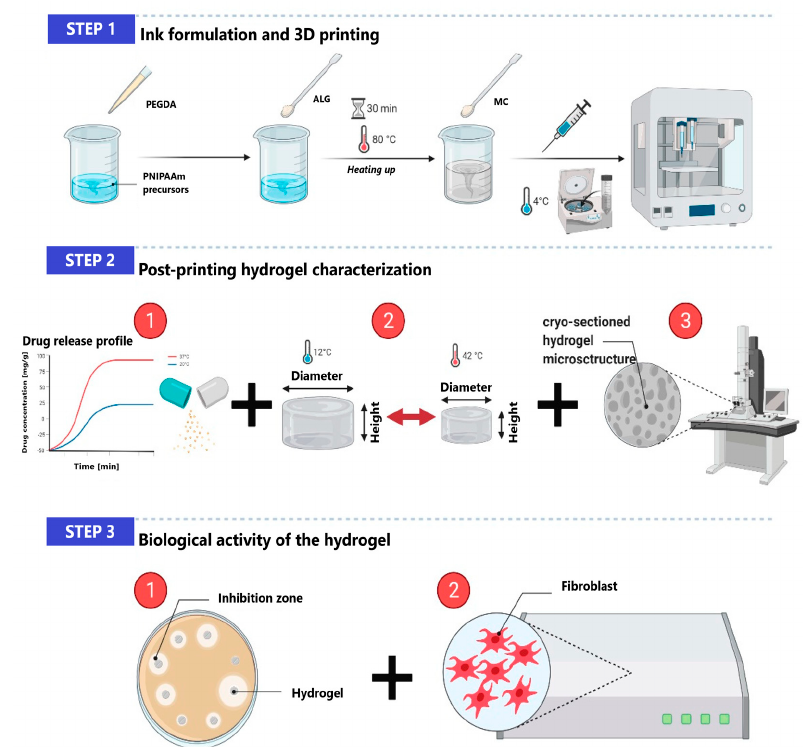
Figure 10. Preparation, characterization, and biological activity of 3-D printed hydrogel. Reprinted from [154], Bioengineering 2021.